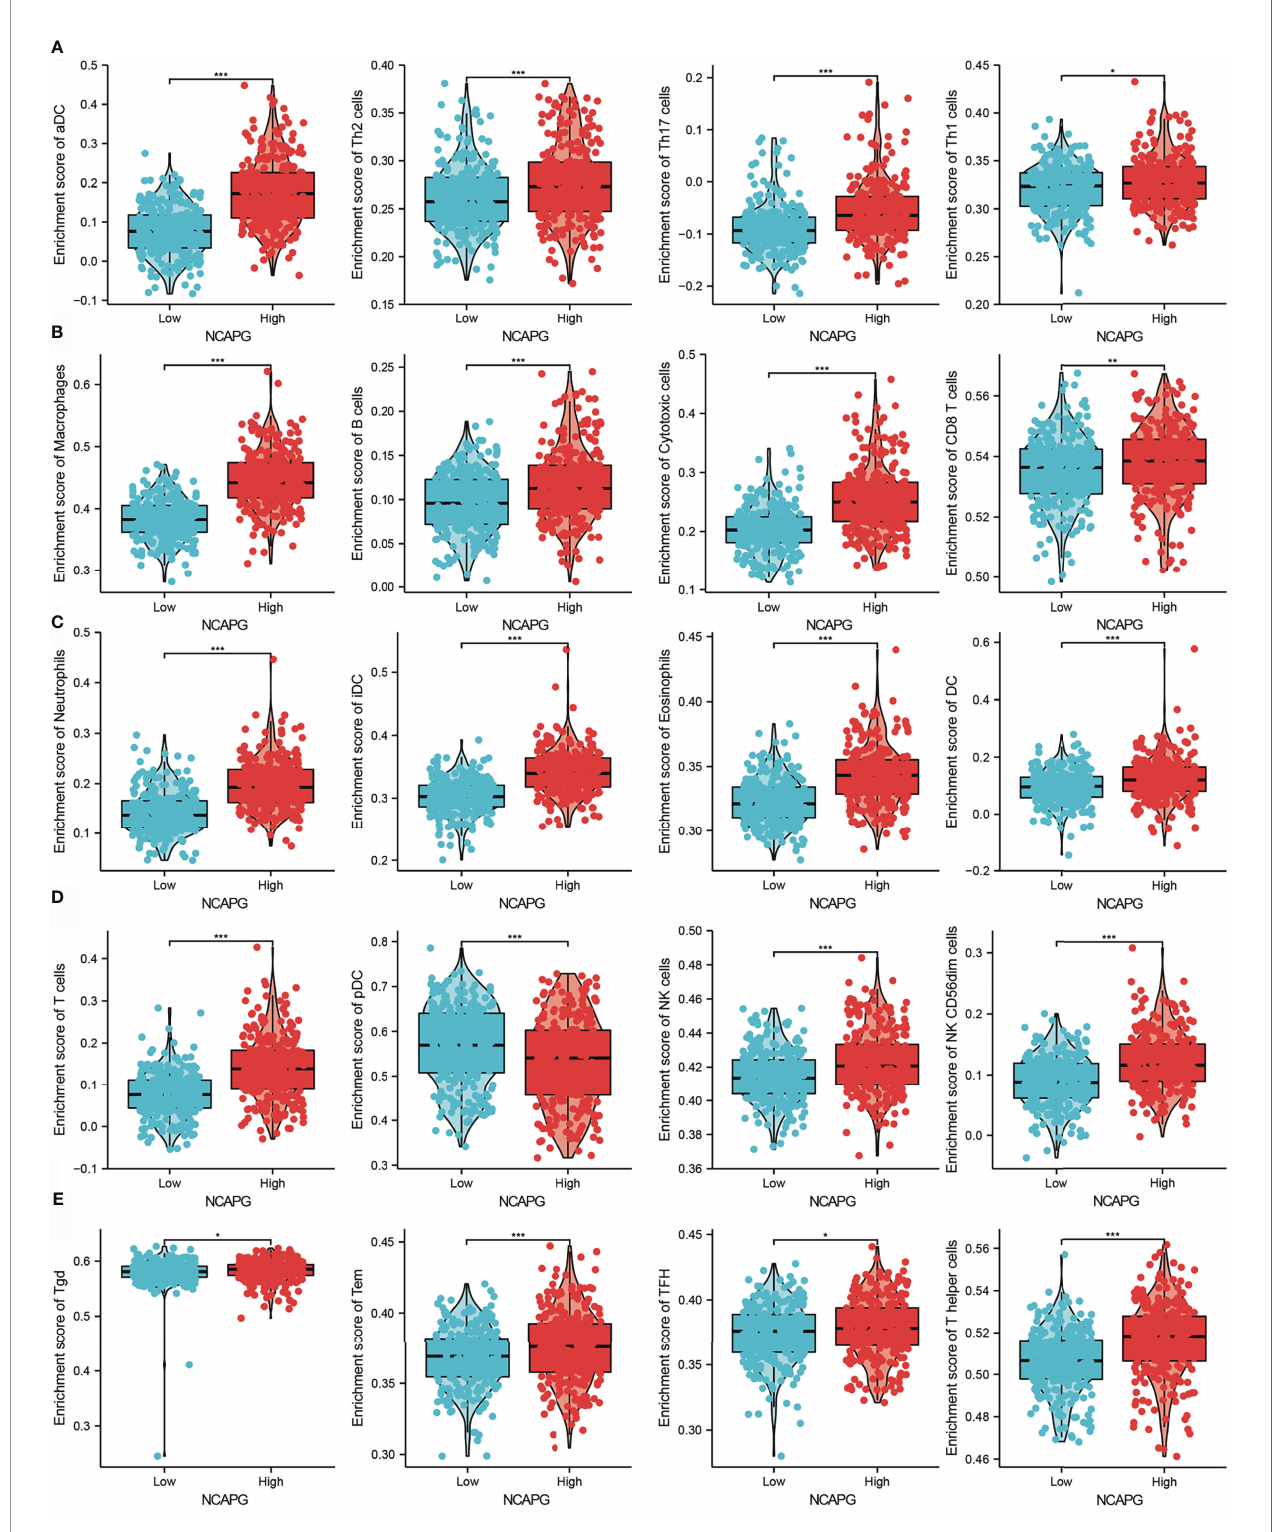
FIGURE 8 | Correlation between NCAPG expression and immune cell in fi ltration. (A – E) Comparison of the levels of in fi ltration of multiple subtypes of immune cells in the high- and low- expression groups, * P <0.05, ** P <0.01, *** P